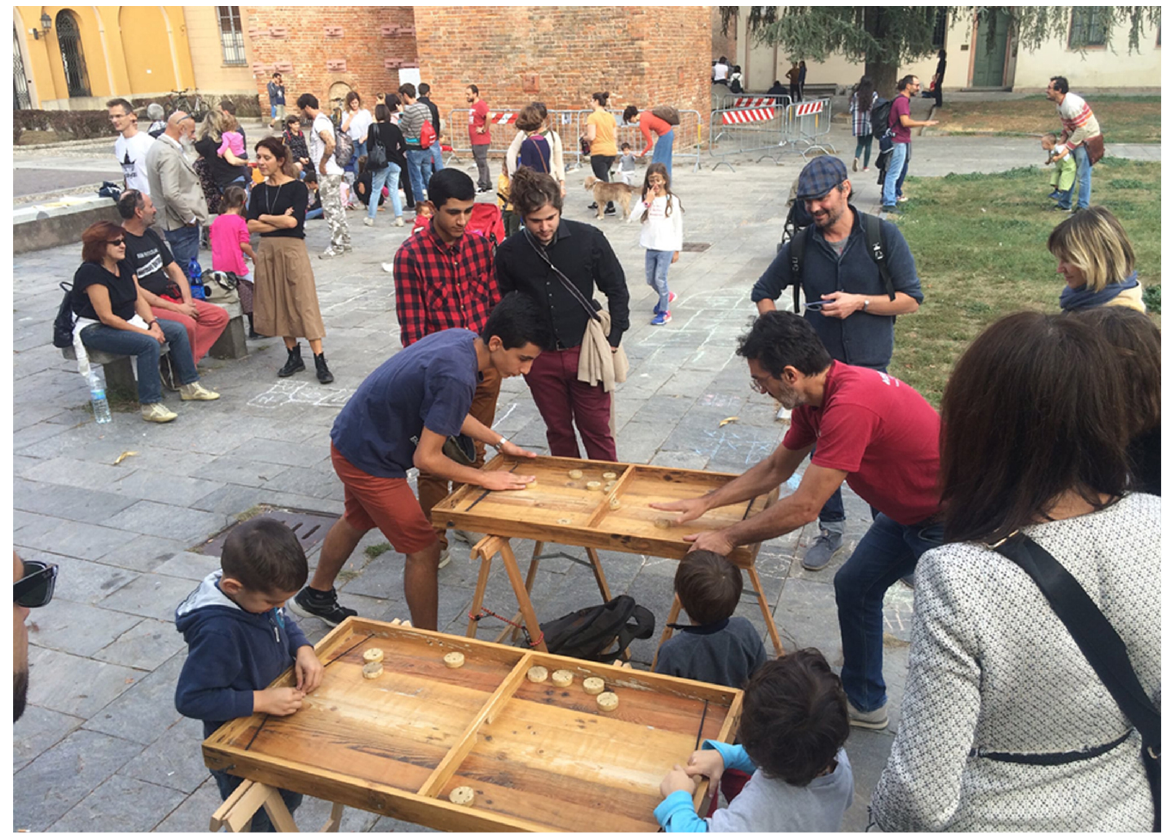
Piazza Leonardo da Vinci, bike repair session and temporary uses during the Giocanda Festival (photo no. 13 by Ciclofficina Pavia, photo no.14 by Giocanda